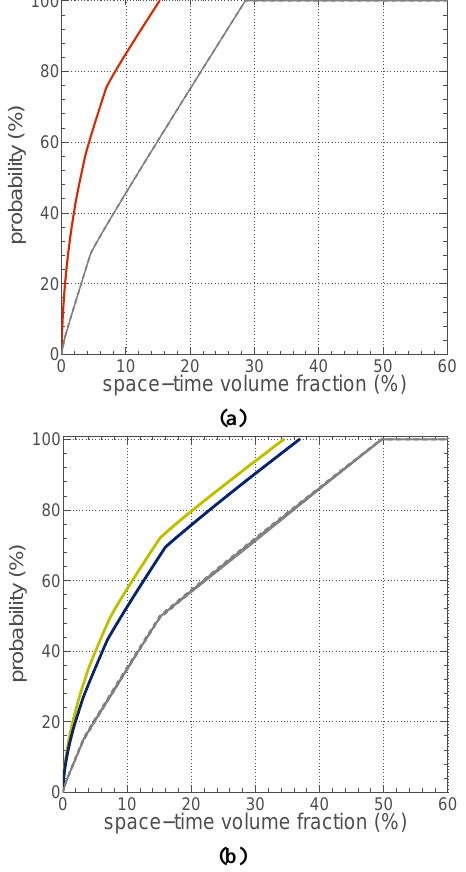
Fig. 7. Localization of horizontal distributions among sources of similar depth as measured by P % | T ∗ ( A ) obtained for (a) T ∗ = 215K (red) and (b) 200K (yellow) and 185K (blue). Also plotted the mean (solid grey) and mean ± standard deviation (dashed grey) of P ˜ % | T ∗ ( A ) obtained from 1000 realisations of ˜ ρ 100hPa . The differ- ences between the latter three curves is small for the range of values plotted here. The distributions are calculated for all-sky conditions, using the ALLSKY- 1T 0 ensemble launched at 100hPa (see text for more